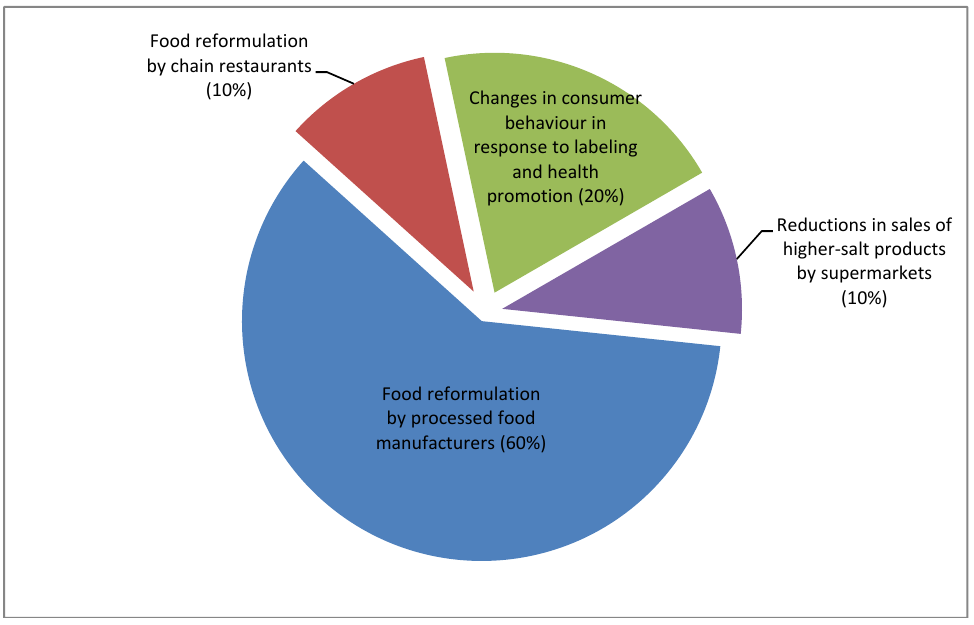
Figure 3. Pie-chart showing indicative allocation of responsibility for reducing population salt intake between consumers, food manufacturers, supermarket chains and chain restaurants.